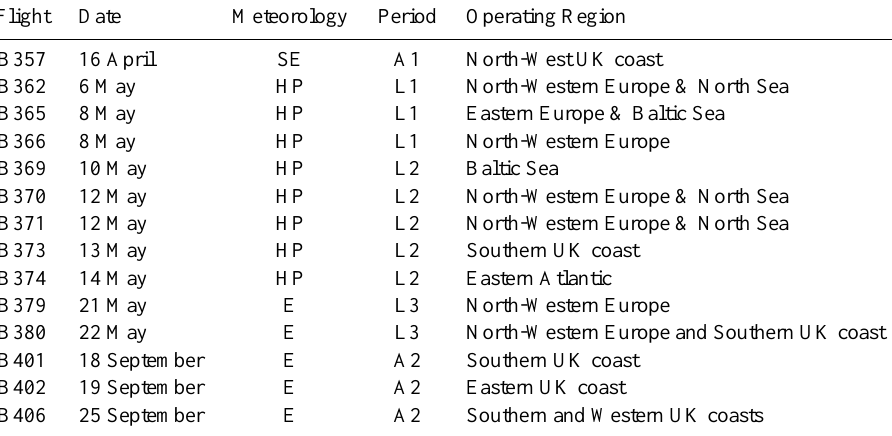
Table 1. Flight summary for ADIENT (B357, B401-B406) and LONGREX (B362-B380) operations included in this study. All flights were conducted during 2008. The predominant meteorological conditions present are summarised, where SE refers to south-easterley, E refers to easterley and HP refers to the high pressure system during the initial LONGREX flights described in the main text. Also included is an indication of which period each flight took place during, which are abbreviated as A1 (ADIENT-1) and A2 (ADIENT-2). The LONGREX flights refer to the 3 periods in the main text, which are referred to as LONGREX-1 (L1), LONGREX-2 (L2) and LONGREX-3